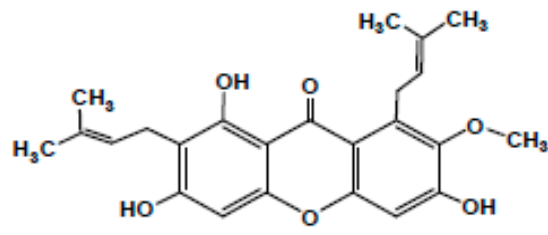
Figure 1. Chemical structure of a-mangostin.